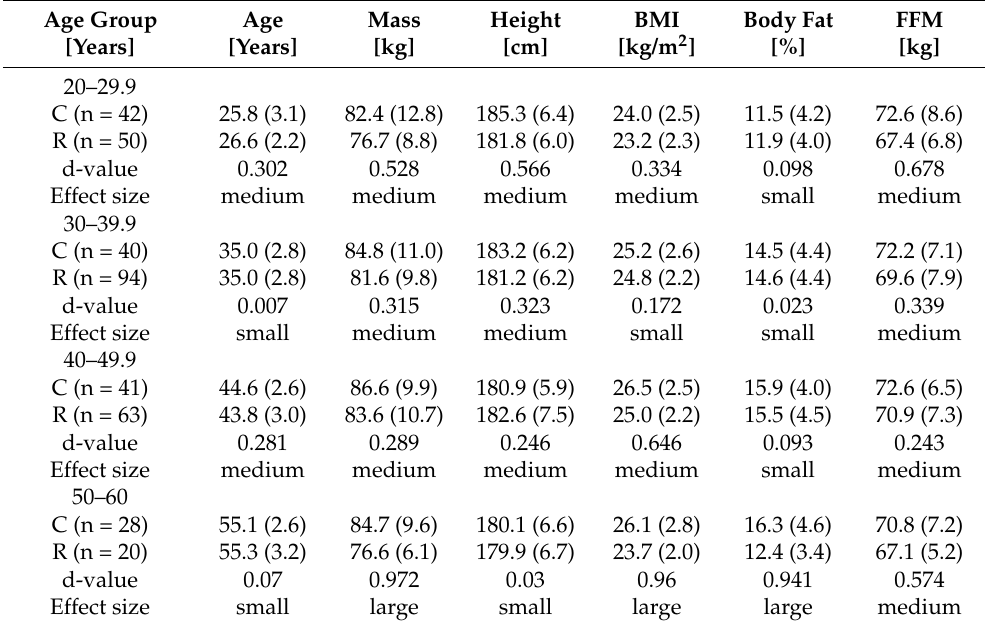
Table 1. Physical characteristics and body composition in male recreational cyclists (C) and run- ners (R).